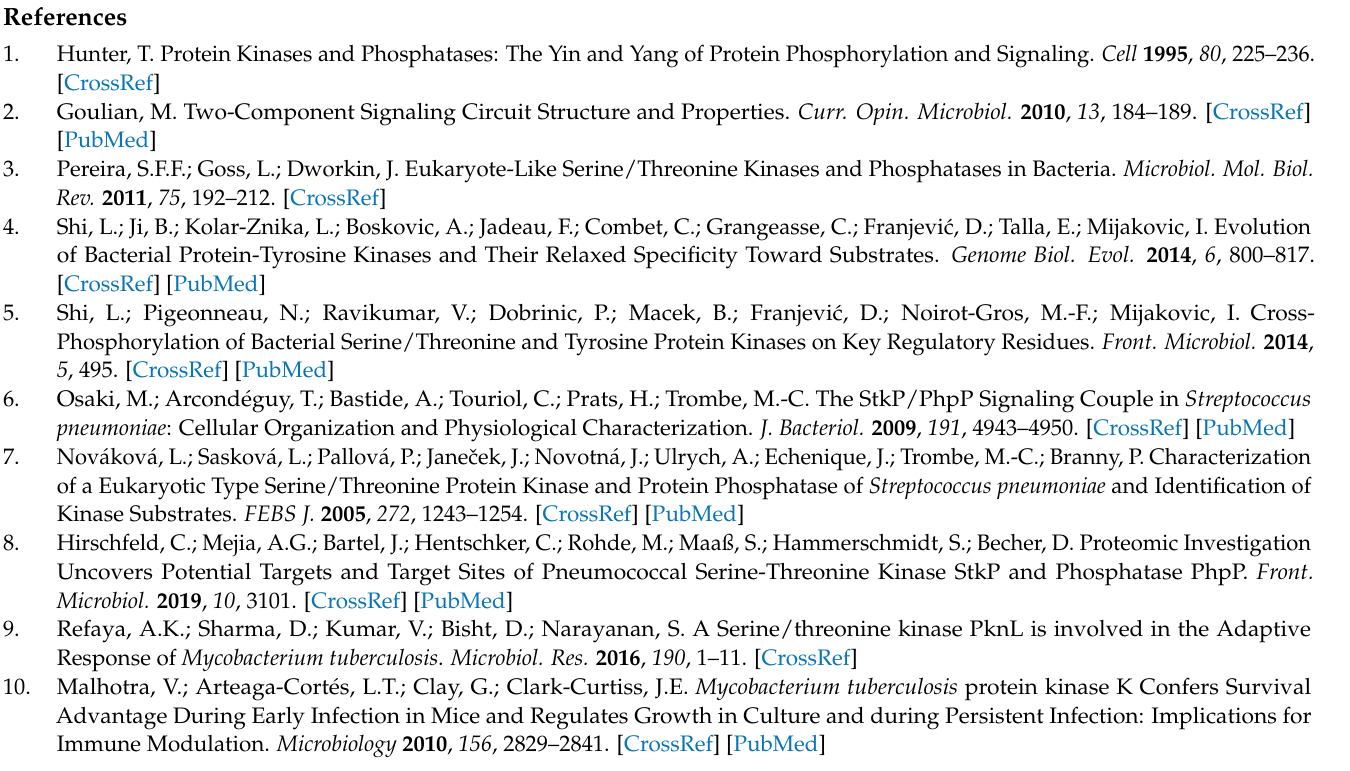
oligonucleotides used in this study. Table S3: The differentially expressed proteins in ∆ stp and ∆ stk compared with WT. Table S4: Proteins identified with changed abundance after phosphopeptide enrichment in ∆ stp and ∆ stk compared with